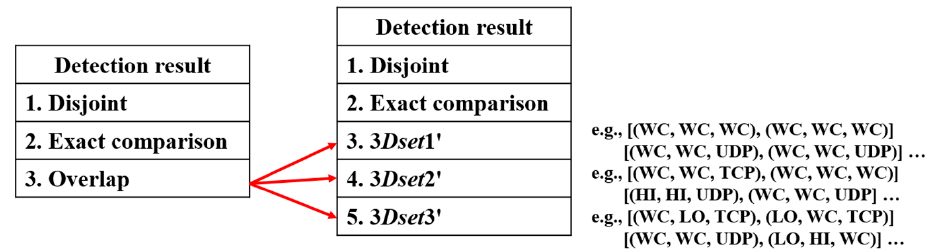
Figure 2. Five results of combined comparison.